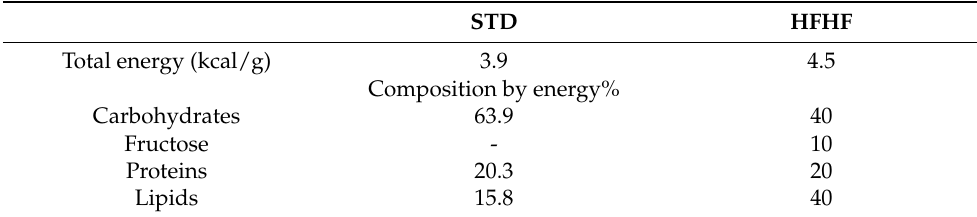
Table 1. Nutrient composition of experimental